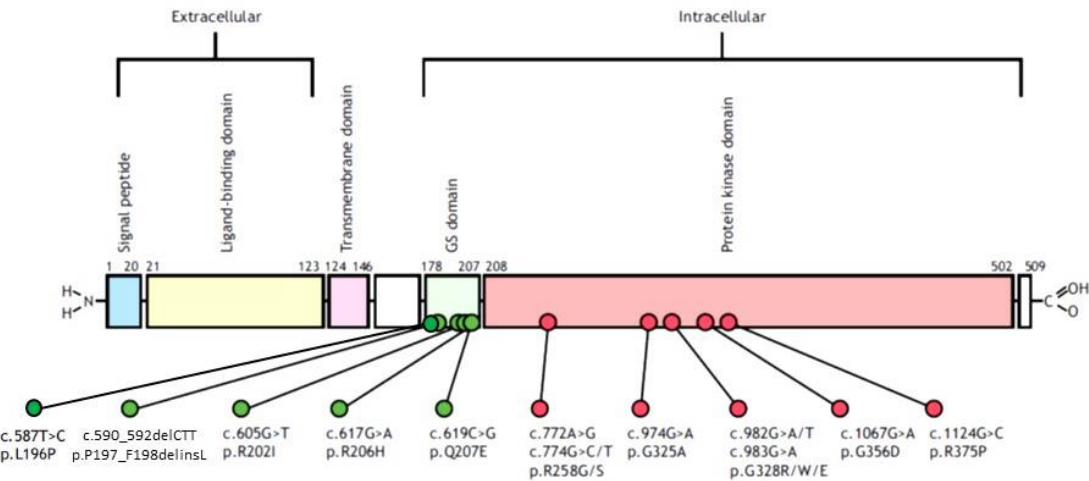
Figure 1. Updated schematic representation of human ACVR, indicating domains and locations of mutations of the ACVR1/ALK2 gene. GS, glycine-serine (from [6], modified).